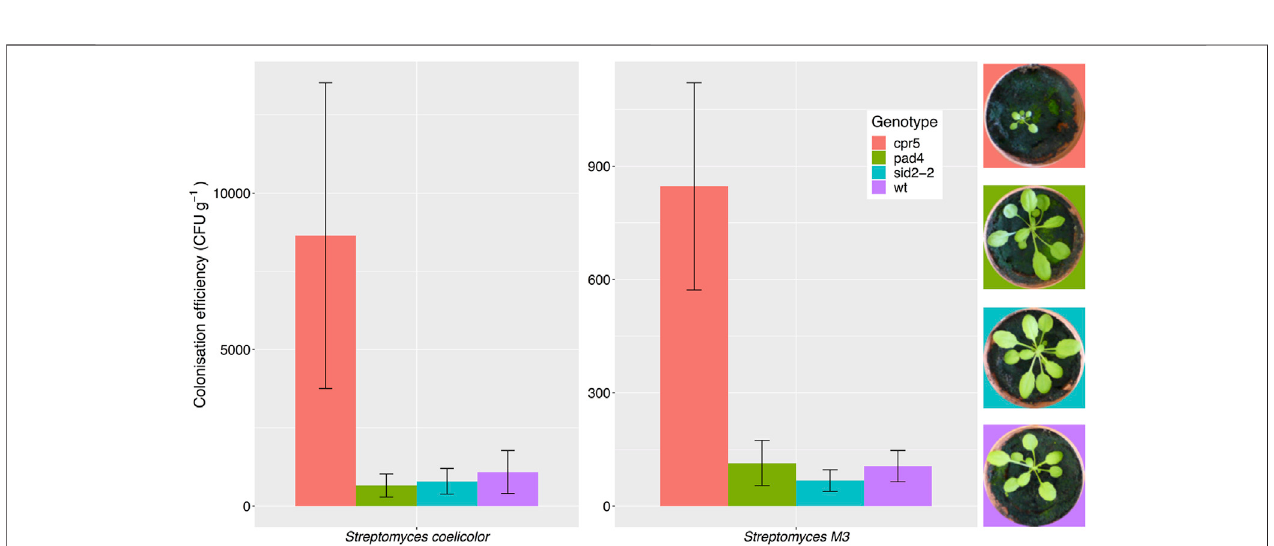
FIGURE 1 | Streptomyces coelicolor M145 and the A. thaliana root endophyte strain Streptomyces M3 show increased root colonization of Arabidopsis thaliana cpr5 plants, which constitutively produce salicylic acid, compared to pad4 and sid2-2 plants, which are de fi cient in salicylic acid production, and wild-type (wt) Col-0 plants. Root colonization was measured as the average colony forming units ( ± SE) of Streptomyces bacteria per gram of root, that could be re-isolated from plants four weeks after germination. N (cid:2) 6 plants per treatment. Plant growth phenotypes are shown for comparison.